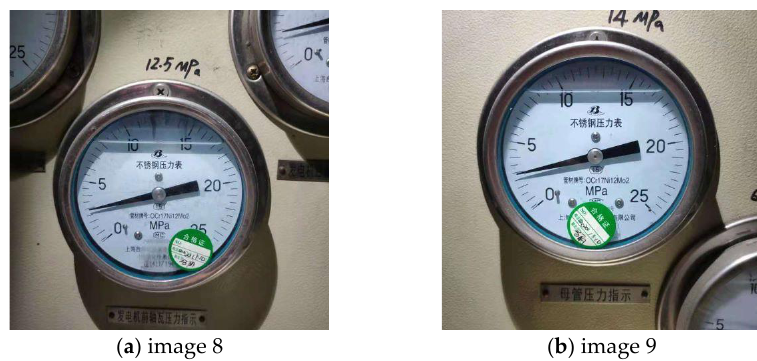
Figure 9. Image with background image interference.